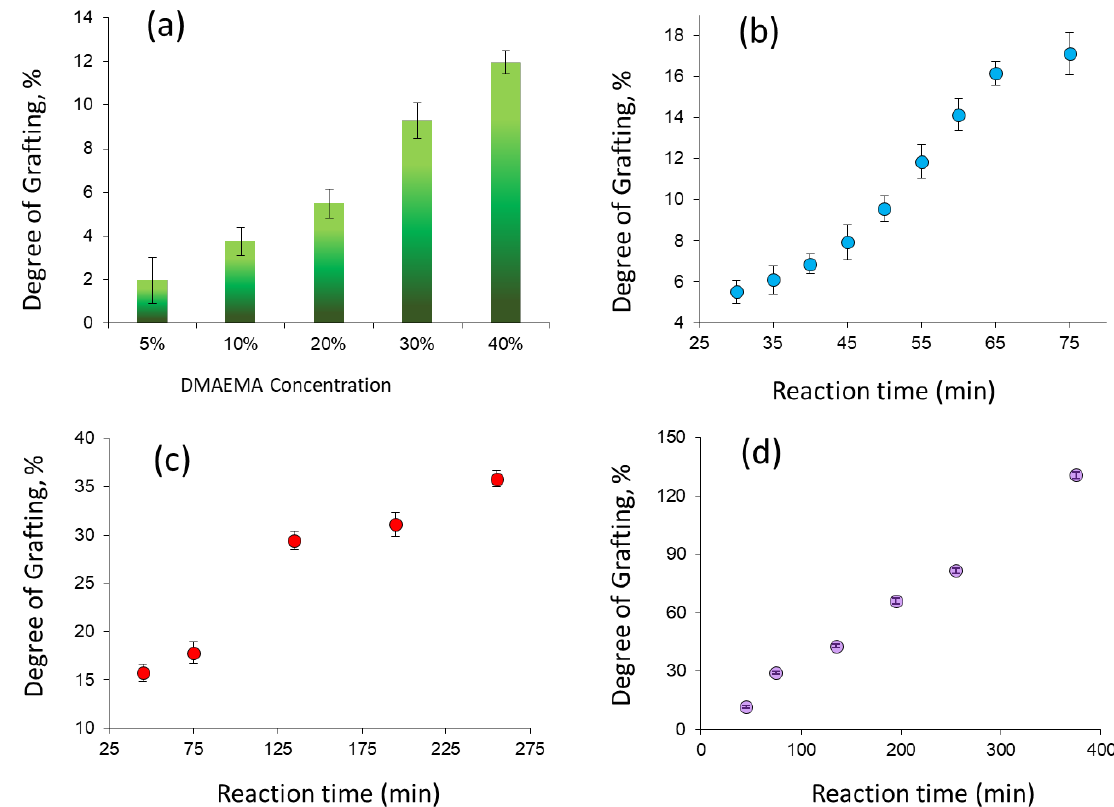
Figure 2. Effect of monomer concentration (t = 50 min) ( a ) and reaction time on the UV-initiated, RAFT-mediated grafting of DMAEMA (20%, v / v ) from PET-TeMs using [DMAEMA]/[RA1] molar ration of 500/1 in water ( b ). Effect of reaction time on the UV-initiated, RAFT-mediated grafting of DMAEMA (20%, v / v ) from PET-TeMs using [DMAEMA]/[RA1] molar ratio of 1000/1 in water ( c ) and in acetone:water (1:1) ( d ).